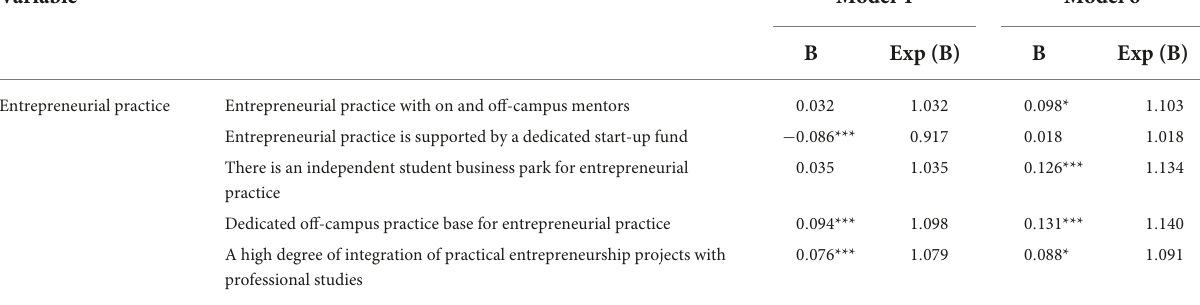
TABLE 6 Results of regression analysis of entrepreneurial practice factors on the dependent